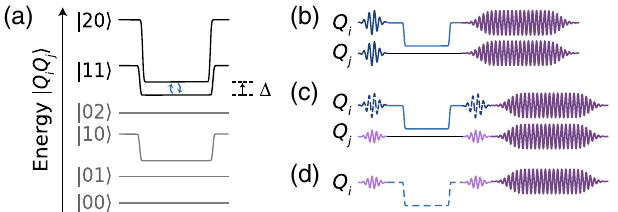
FIG. 10. Energy-level diagram and pulse schemes used for the calibration of the C Z φ gate. (a) Time evolution of the energy levels of the qutrit pair | Q i Q j (cid:4) when a flux pulse is applied to Q i (not drawn to scale). The energy levels directly involved in the gate are shown in black and the interaction between the | 11 (cid:4) and | 20 (cid:4) states is indicated with two blue arrows. (b)–(d) Pulse scheme used to measure the Chevron pattern, the conditional phase and the dynamic phase, respectively. The π pulses, π/ 2 pulses, flux pulses, and readout pulses are shown in dark blue, pink, light blue, and purple, respectively. A dashed line indicates that the measurement is repeated once with, and once without the corresponding pulse.